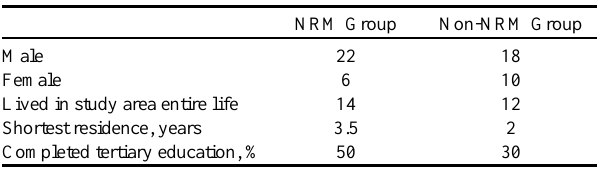
Table 1 . Interviewees